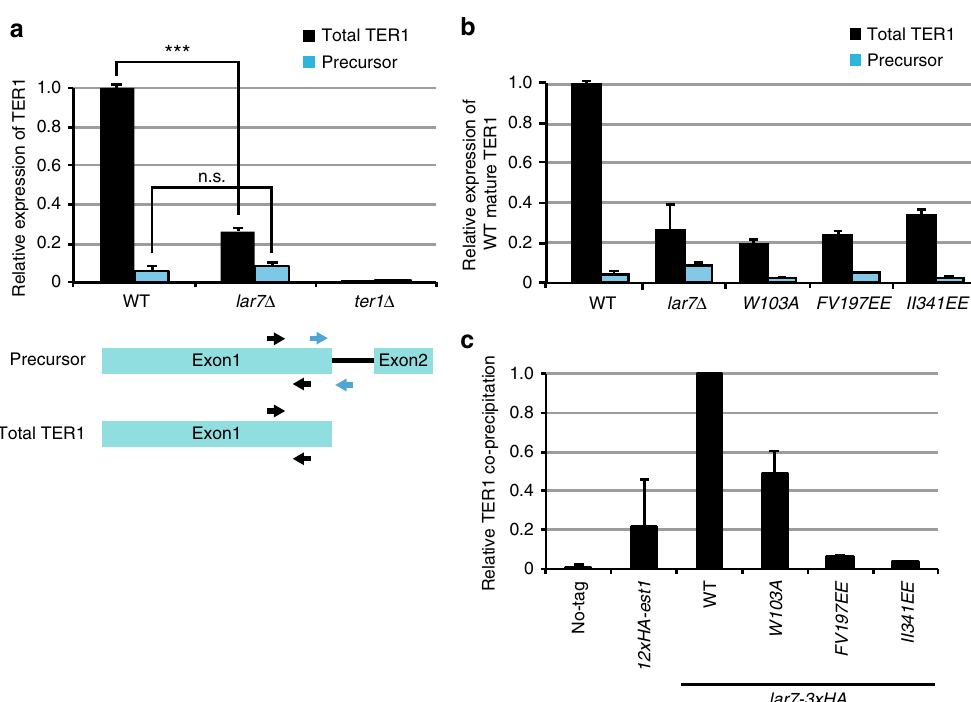
Fig. 3 Lar7 binds and is required for accumulation of mature TER1. TER1 precursor and/or mature mRNA was quanti fi ed using RT-qPCR and normalised fi rst to actin and then to the expression in wild-type cells. a Positions of the primers speci fi c to precursor (blue) and total (black) TER1 are indicated. Signi fi cantly less total TER1 expression was detected in lar7 Δ compared to wild-type (unpaired t test *** at p < 0.001). Data represented as a mean of three independent experiments. Error bars show standard deviation. b Quanti fi cation of mature TER1 in three lar7 point-mutant strains. c Lar7 interacts with TER1 via its RNA-recognition motifs. Presence of TER1 mRNA in lysates following immunoprecipitation using α -HA was measured using reverse-transcriptase quantitative polymerase chain reaction (RT-qPCR) and normalised fi rst to actin mRNA and expressed as immunoprecipitated RNA over total RNA. The ef fi ciency of RNA precipitation in lar7 mutants is represented as a percentage of enrichment relative to wild-type Lar7-3xHA. The TER1-binding protein Est1 was used as a positive control. Data is represented as a mean of two independent experiments. Error bars show standard